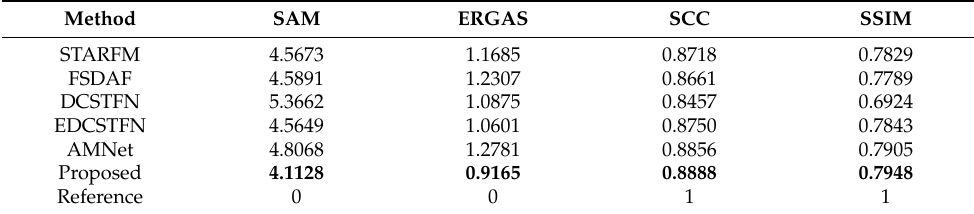
Table 4. Index performance of each method on the LGC